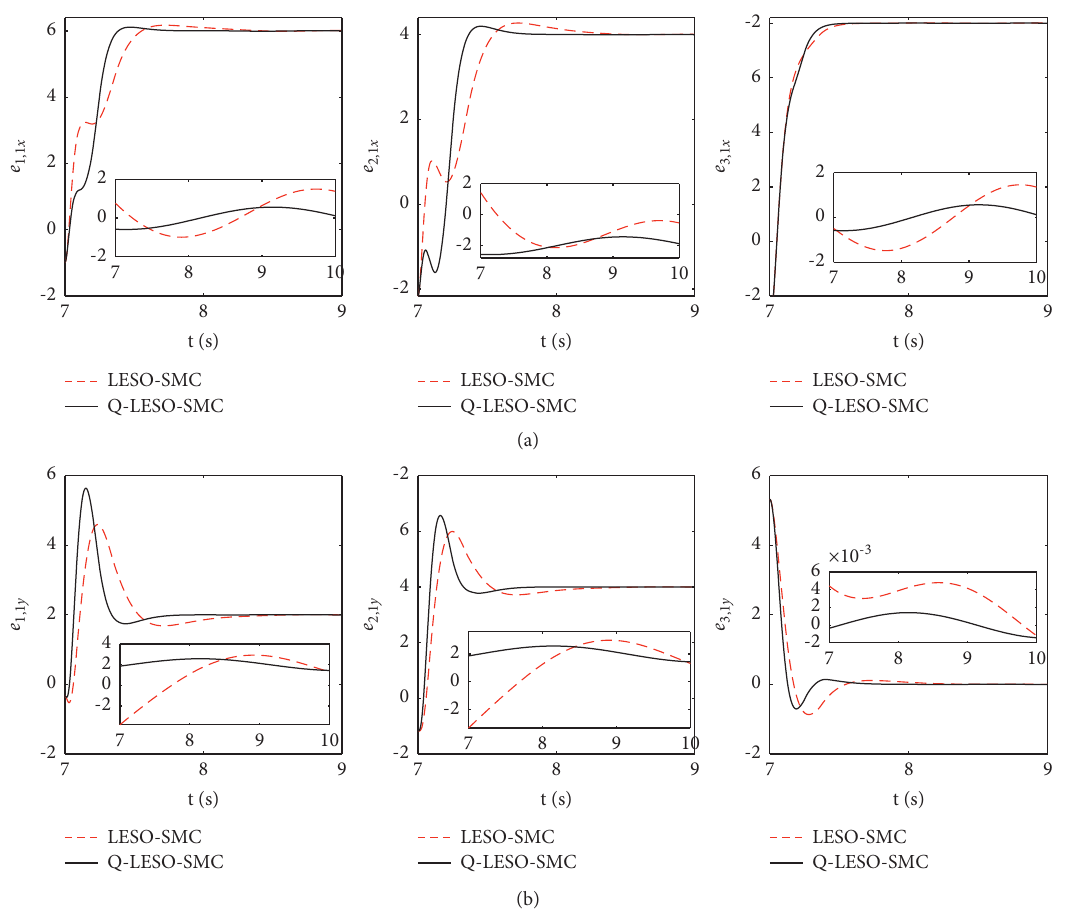
Figure 14: The formation tracking position error e i, 1 in Case B(a) The formation tracking position error of the x -direction of the i th agent i � 1, 2, 3. (b) The formation tracking position error of the y -direction of the i th agent i � 1, 2,